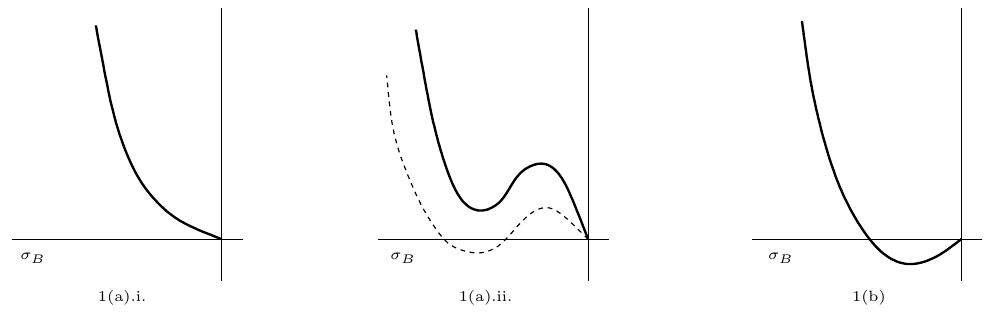
Figure 3 . E(cid:11)ective potential in the unHiggsed phase for A u